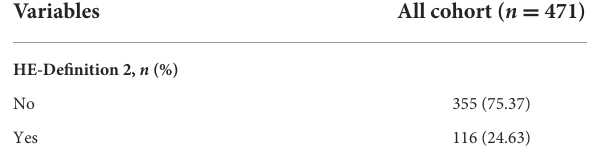
TABLE 1 Baseline characteristics of the included